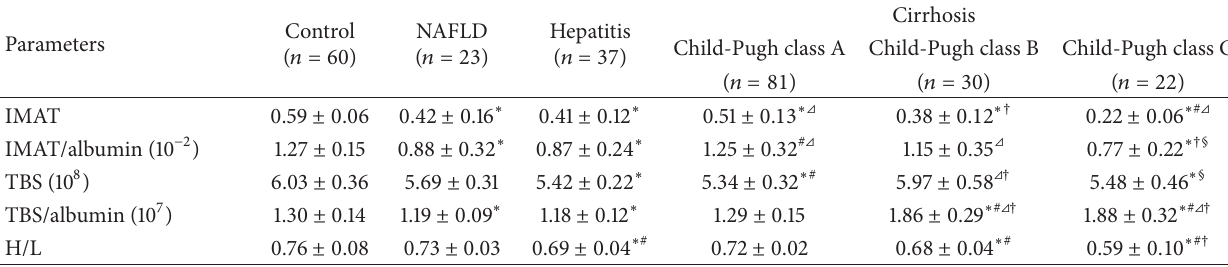
Table 3: Functional albumin parameters in different subjects